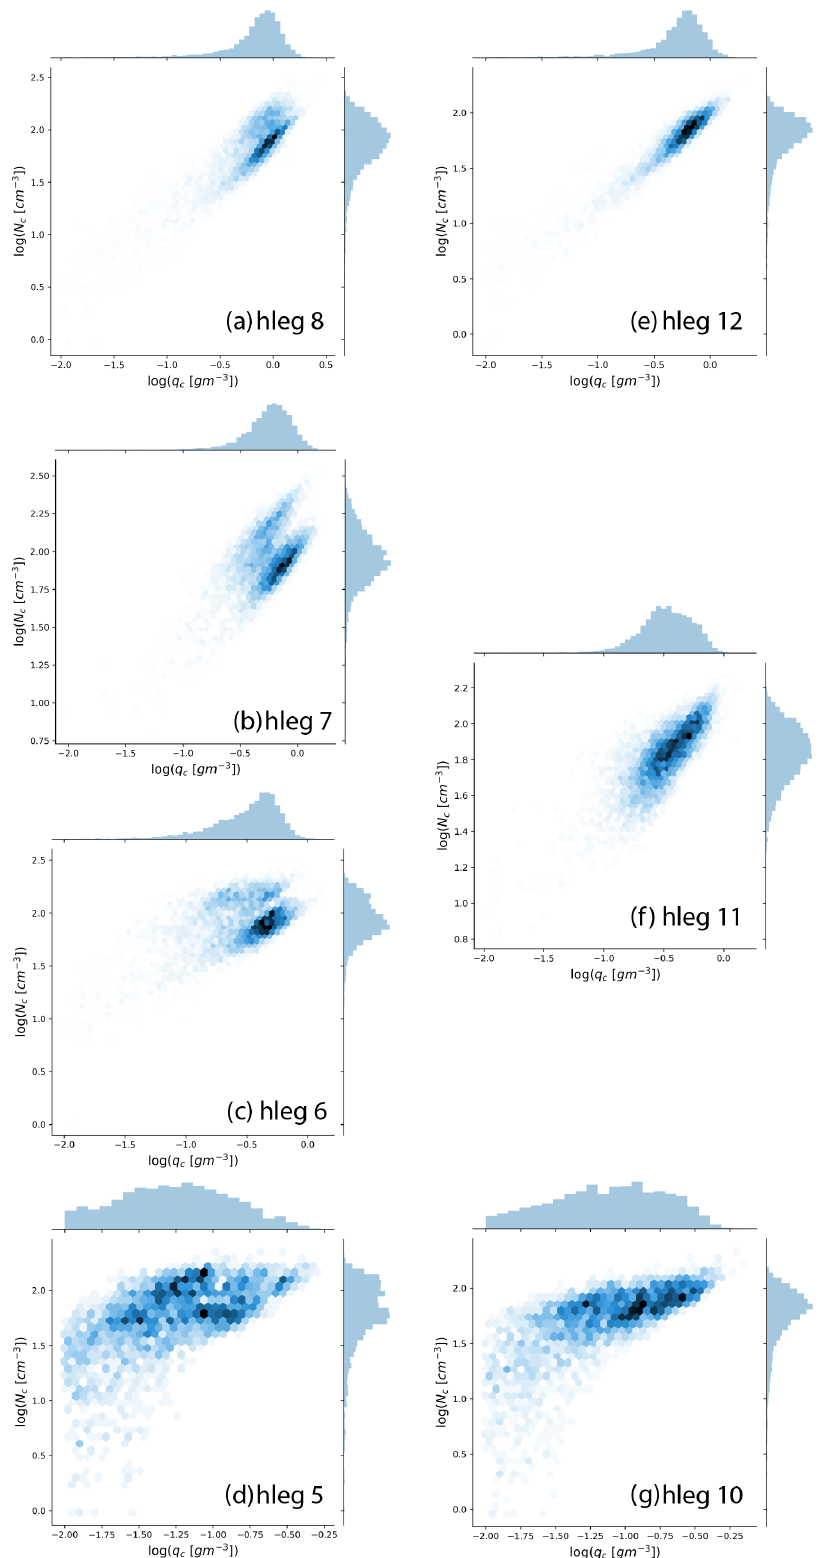
Figure 5. The joint distributions of q c and N c , along with the marginal histograms, for the seven selected hlegs from the 18 July 2017 RF. As in Fig. 3, the plots are ordered such that (a) hleg 8 and (e) hleg 12 are close to cloud top; (b) hleg 6, (c) hleg 7, and (f) hleg 11 are sampled in the middle of clouds; and (d) hleg 5 and (g) hleg 10 are close to cloud